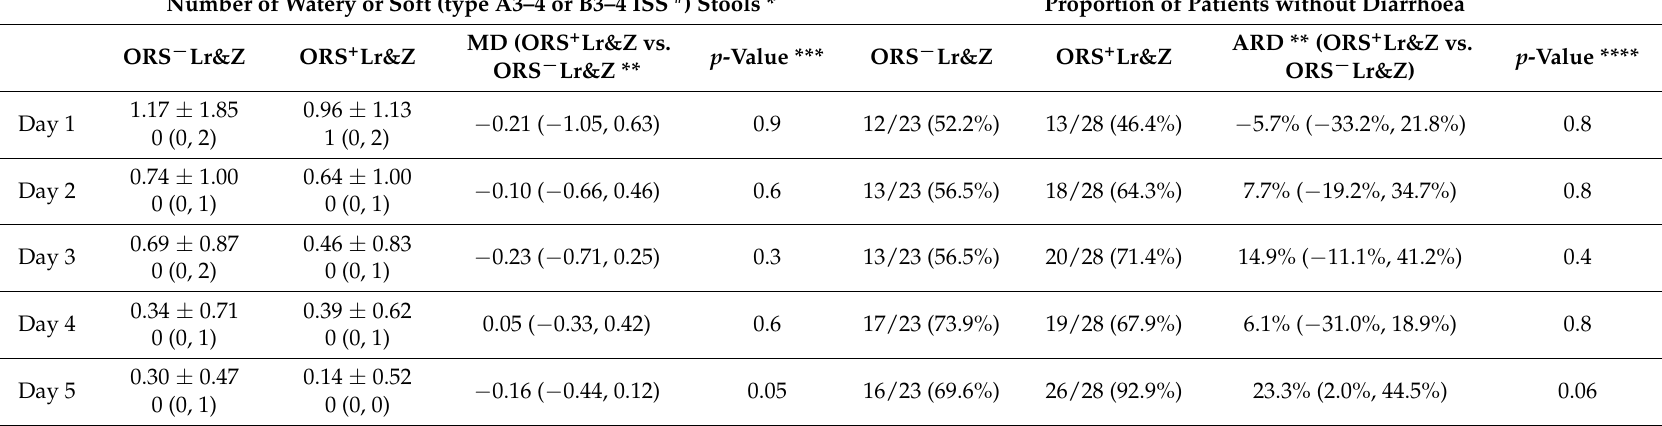
Table 4. Resolution of diarrhoea during the study